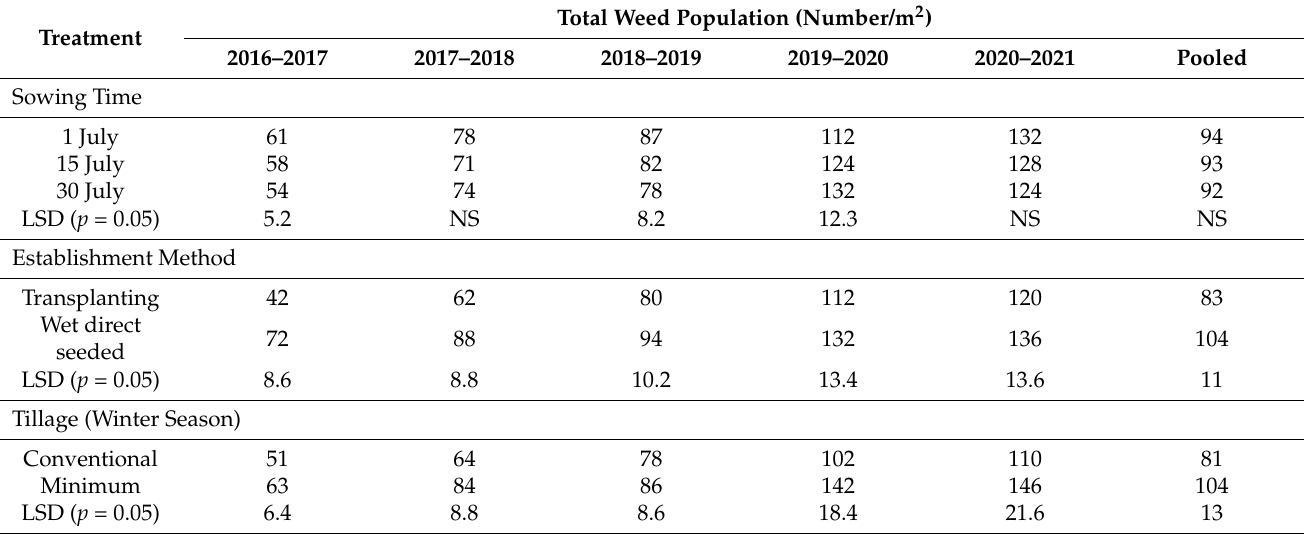
Table 8. Total weeds population at 45 days after sowing in maize during the 5-year period. Total Weed Population (Number/m 2 Treatment